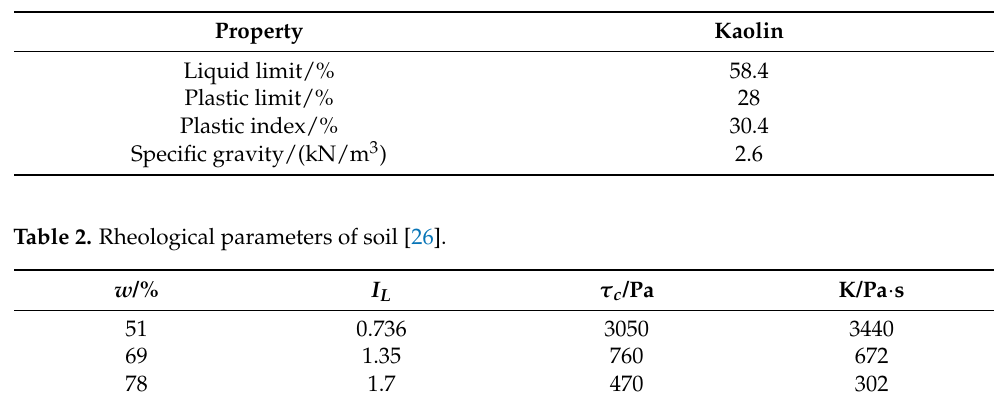
Table 2. Based on the above soil parameters, a shield applied in the Suzhou Metro Tunnel of Line S1 with a cutter head diameter of 6.86 mm and a shield shell diameter of 6.83 m was selected to analyze the flow behavior of the soil. Table 1. Soil index properties [26].